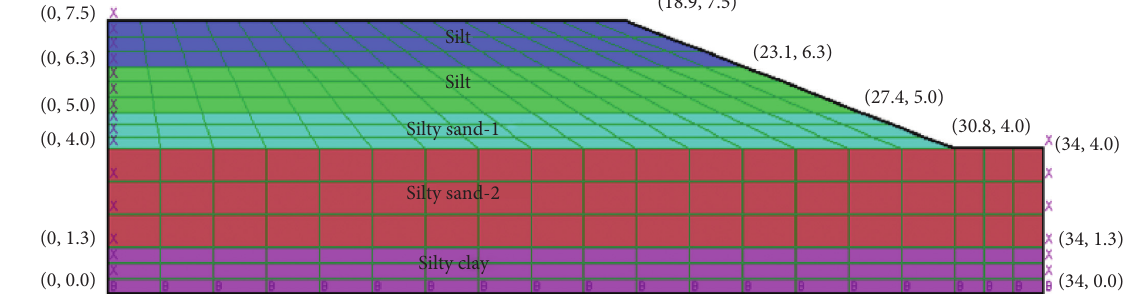
Figure 5: The mesh of Wildlife Site Array using the PM4sand Table 4: Soil parameters of the hardening soil small model.